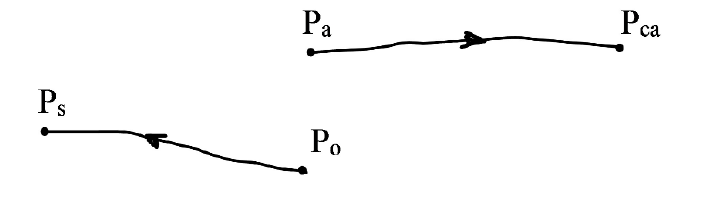
Figure 1. The two paths of the solution, where: P o is the original point of conditions of the problem. P s is the solution point of the problem. P a is the point of the assumed to-be-original-conditions of the problem. P ca is the contradicting point to P a